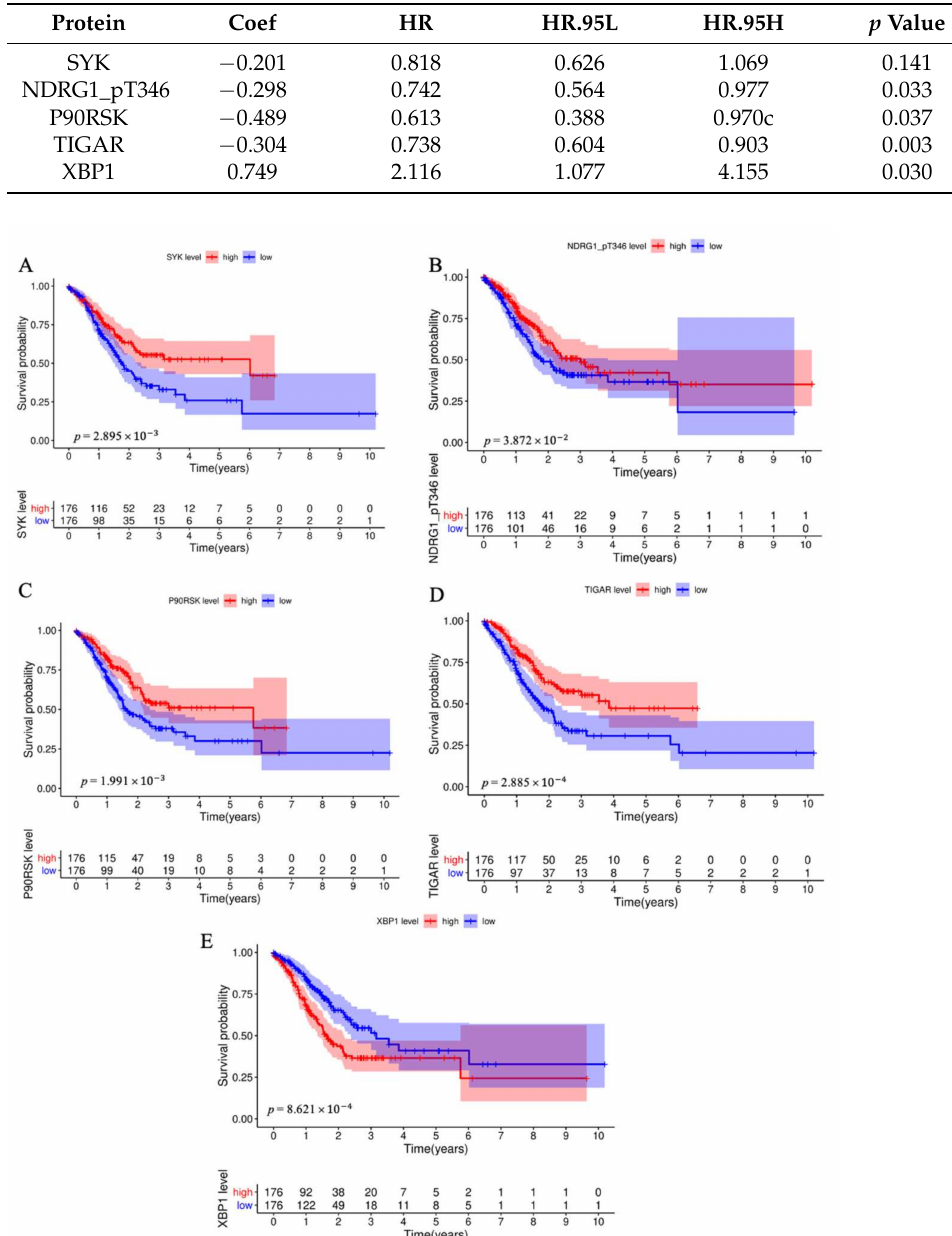
Figure 1. Survival analysis for each model protein. Low SYK expression ( A ), NDRG1-PT346 ( B ), P90RSK ( C ), and TIGAR ( D ) and high XBP1 expression ( E ) were positively associated with poorer overall survival of STAD